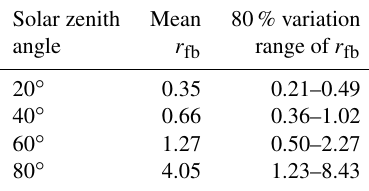
Table 3. The mean values and variation range of the ratio r fb of backward to forward scattering for diverse solar zenith angle values for all profiles measured in March and April 2009. These values represent the surface scattering contribution